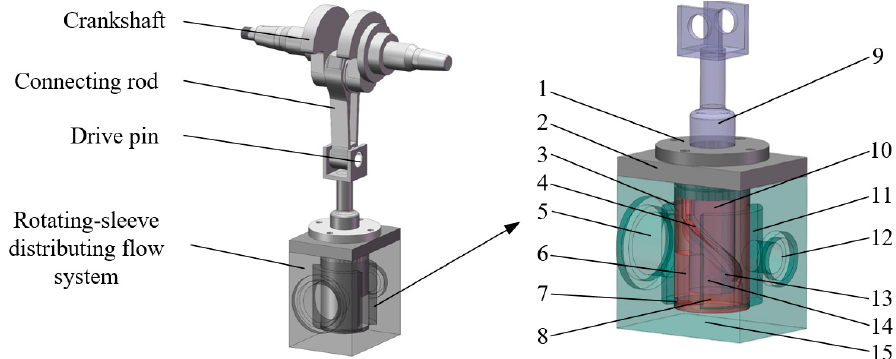
Figure 2. Structure principle of the rotating-sleeve distributing flow (RSDF) system. (1) Guide sleeve; (2) Cover; (3) Loading chamber; (4) Inner cam groove; (5) Oil inlet; (6) Valve port; (7) Damping groove; (8) Pump chamber; (9) Plunger; (10) Rotating sleeve; (11) Collecting chamber; (12) Oil outlet; (13) Drive pin; (14) Compression spring; (15) Pump body.